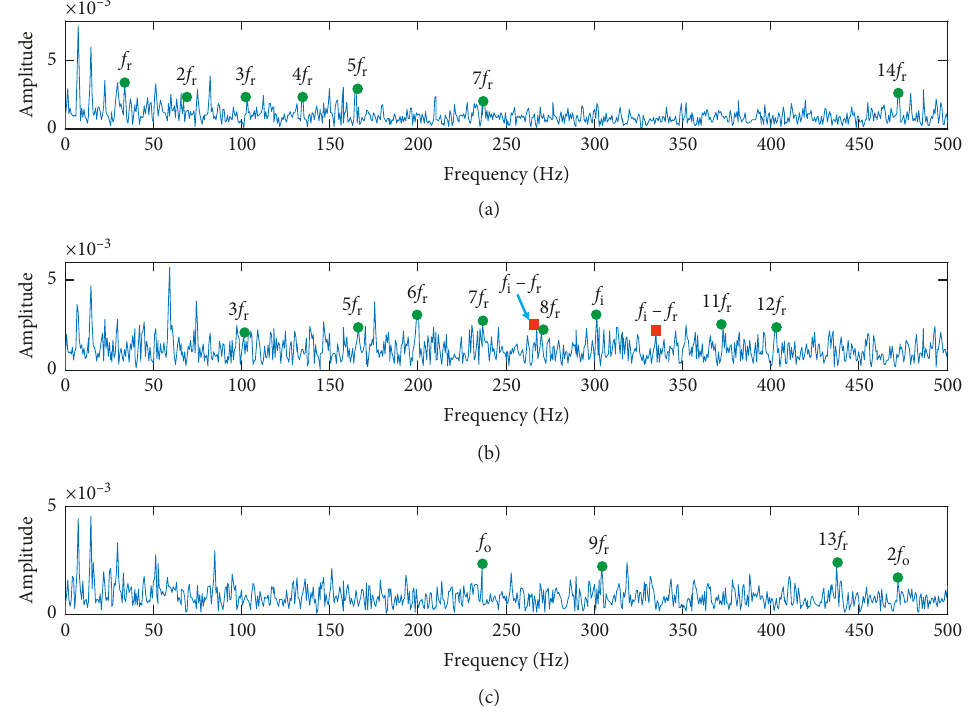
Figure 16: The frequency domain diagram of the signals in Figure